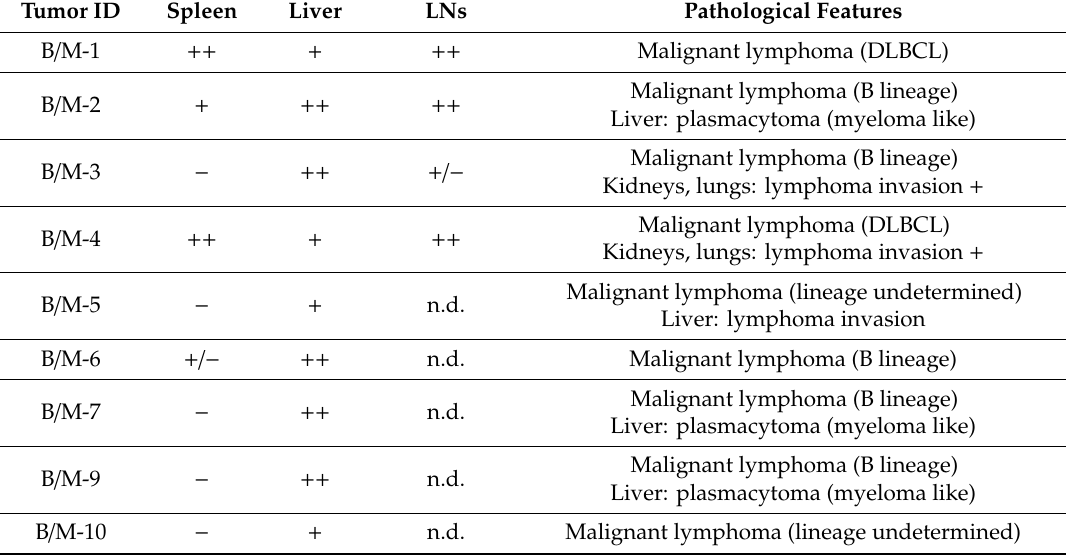
Table 1. Organs of tumor development in Ig - ganp Tg mice.